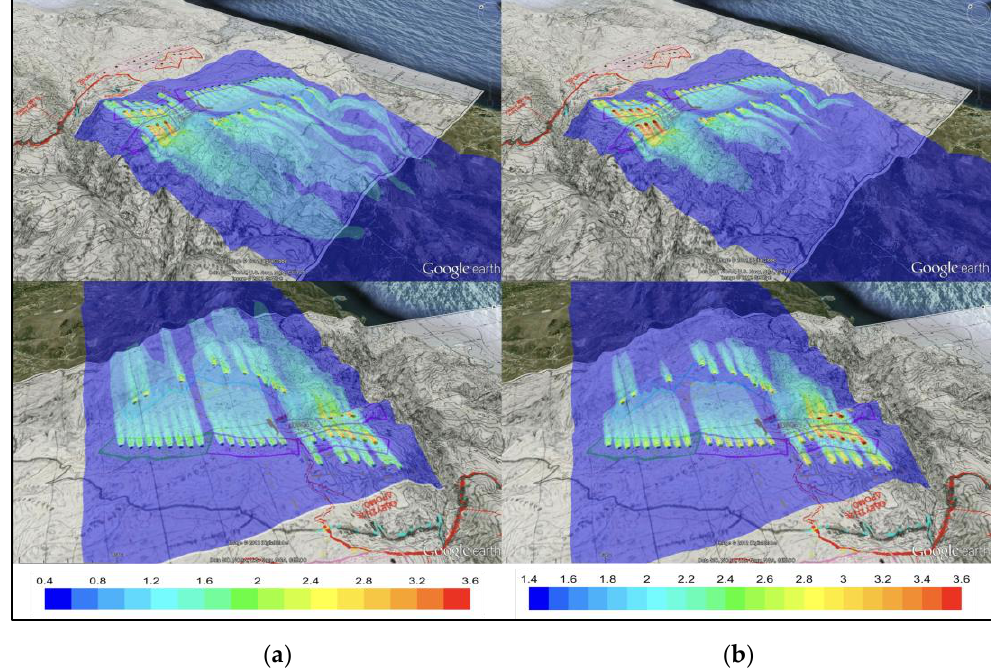
Figure 5. Planes of turbulence kinetic energy k (m 2 /s 2 ) at HUB height, projected on the complex topography of Chios island. ( a ) 𝑇𝐼 = 8% . ( b ) 𝑇𝐼 = 15% .